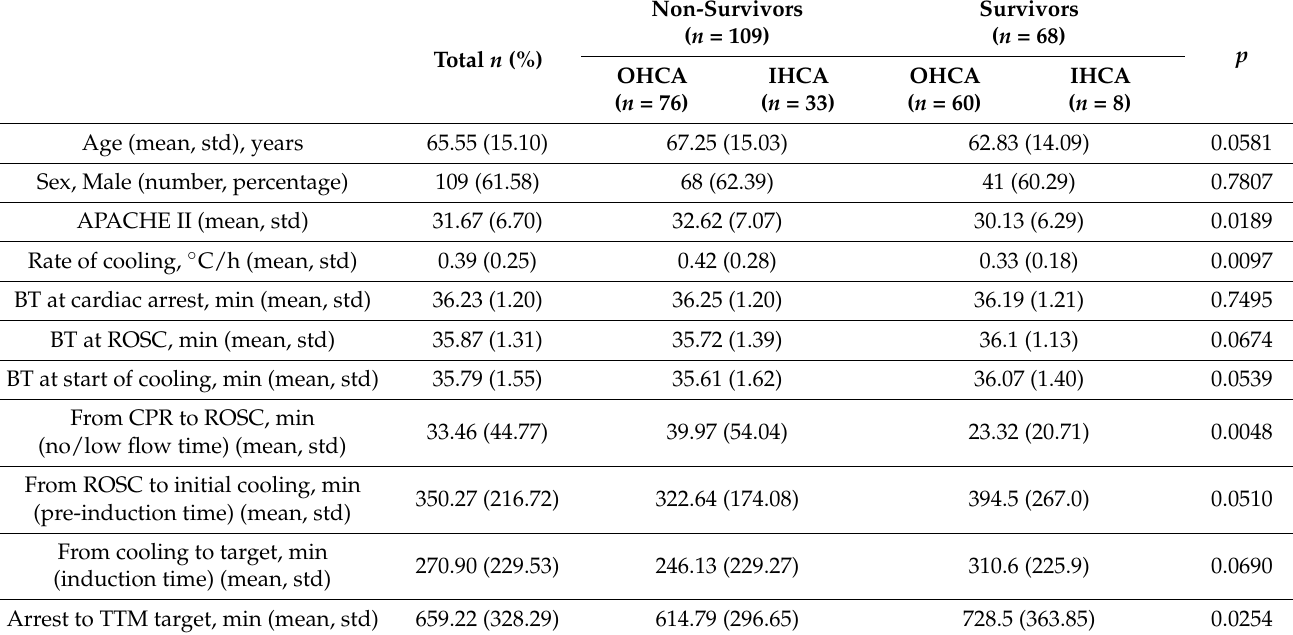
Table 1. Comparisons of the survivors and non-survivors at day 28 with